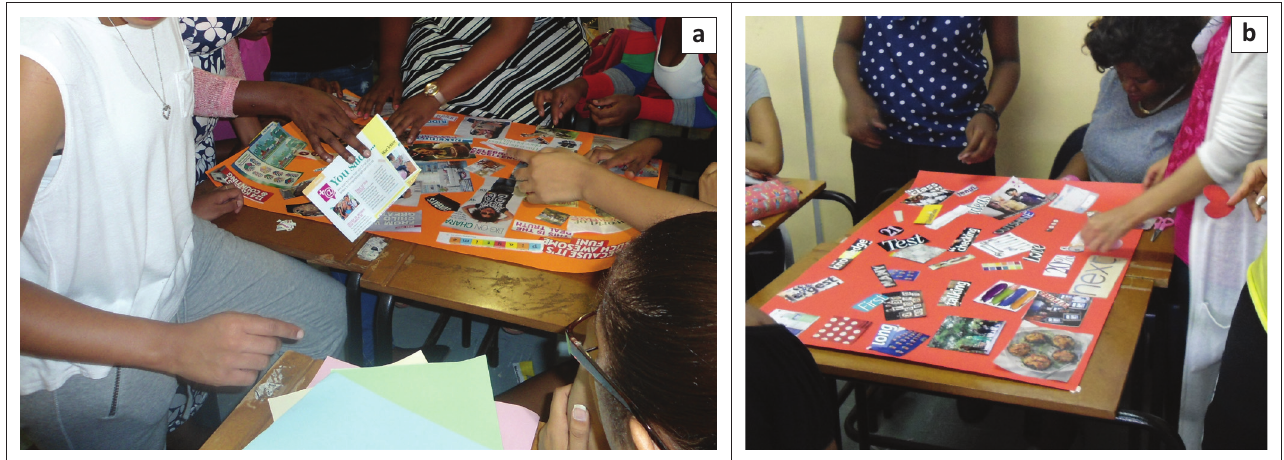
FIGURE 1: Student teachers engaging in the process of making a collage in a and